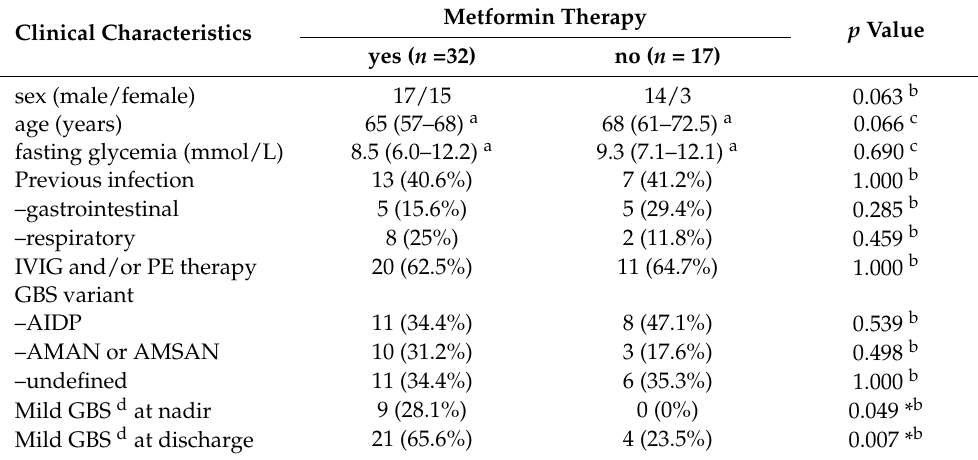
Table 2. Clinical characteristics of GBS patients with type 2 diabetes.